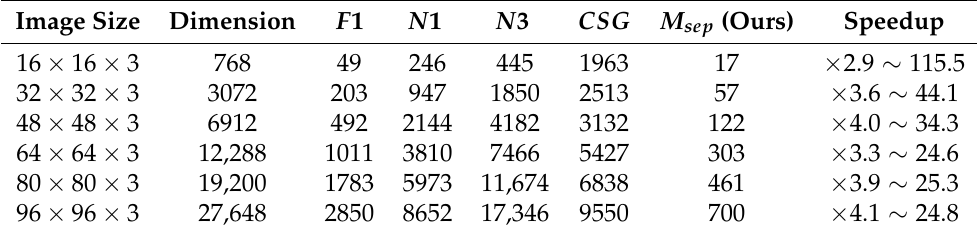
Figure 3 and Table 5 show how computation time changes for various sample